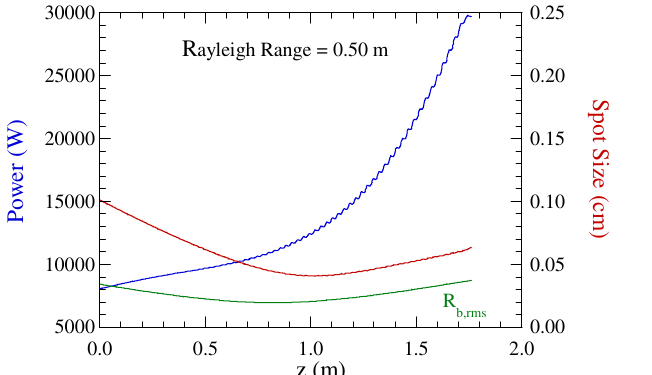
FIG. 10. (Color) Evolution of the power (blue), optical spot size (red), and rms beam radius (green) for a Rayleigh range of 0.8 m.